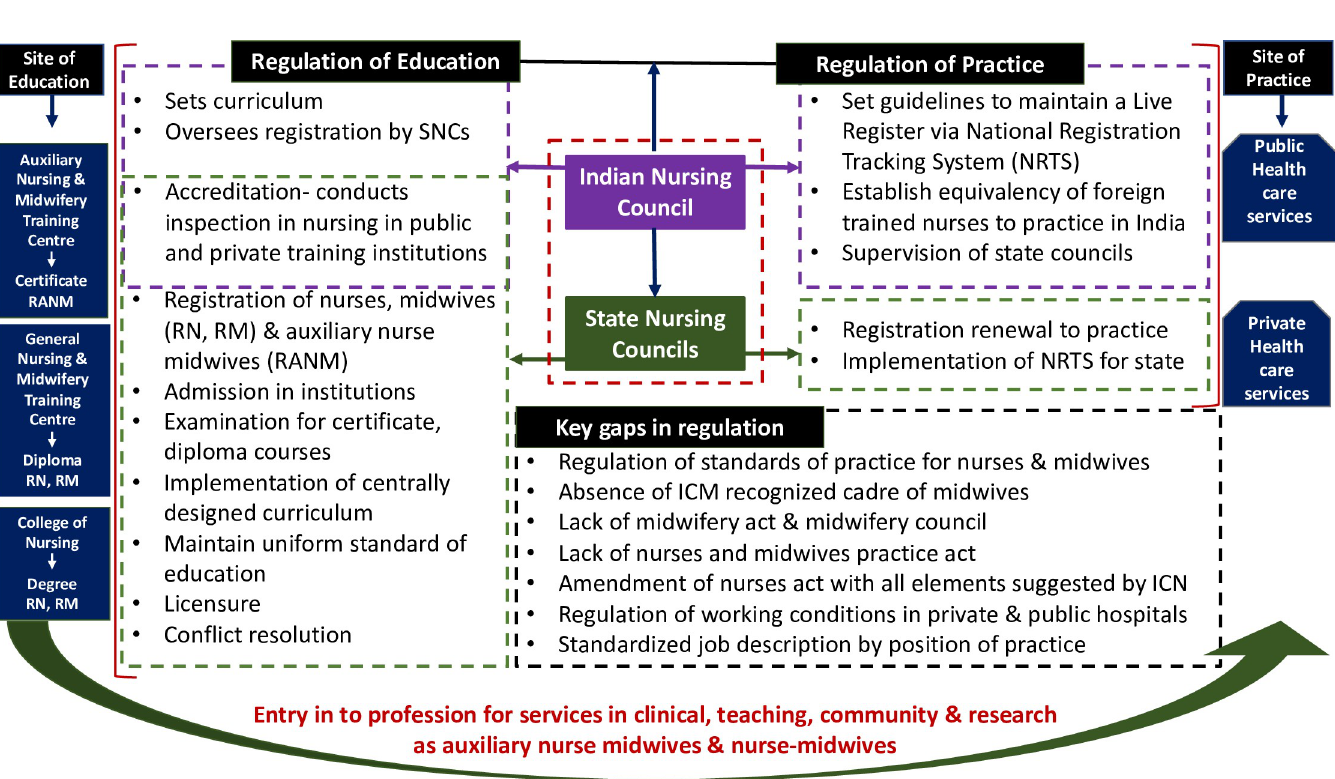
Fig 1. INC and SNC’s role and gaps in regulation of nursing & midwifery in India (author’s original)